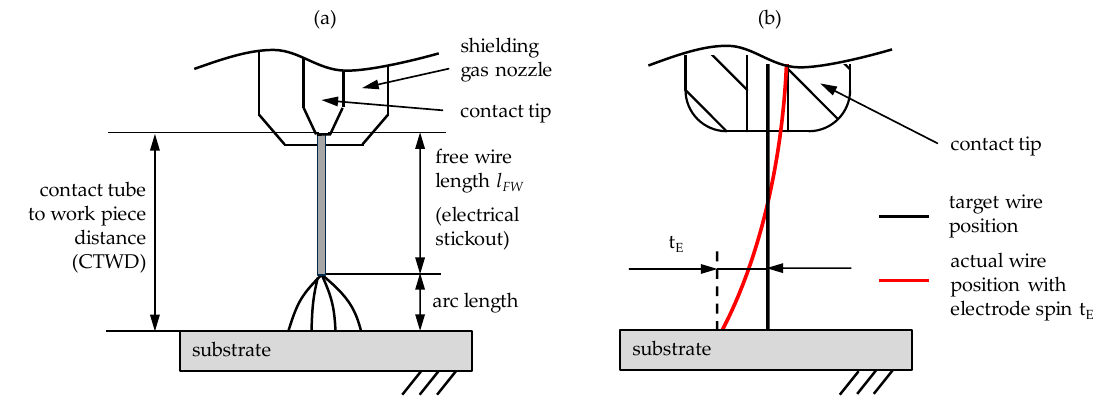
Figure 1. ( a ) Definition of contact tube to work piece distance (CTWD) and ( b ) effect of the electrode spin on wire positioning in gas metal arc welding [26 – 28].